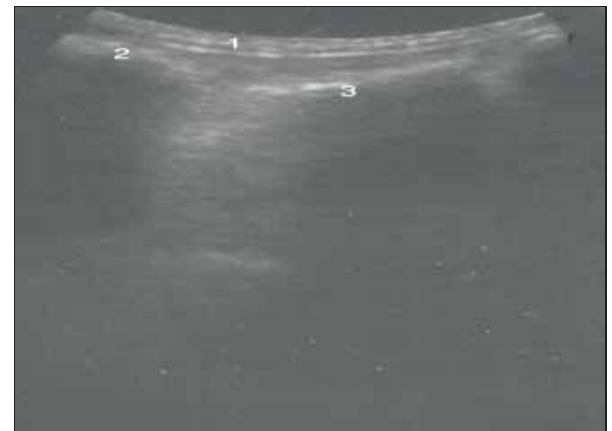
Figure-1: Ultrasonography of healthy goat's rumen imaged at left 12 ICS shows abdominal wall (1) hyperechoic ruminal wall (2) and hypoechoic ruminal content (3). Table-2: Ultrasonographic differences between healthy control and foreign body impacted goats. Items Ruminal wall thickness/ cm